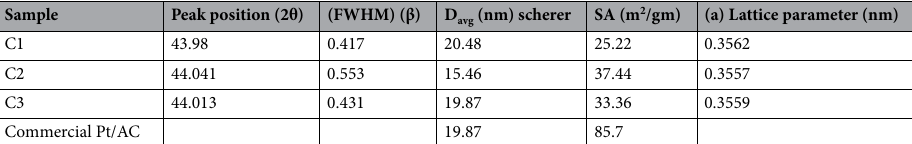
Table 2. Calculated SA values from the XRD